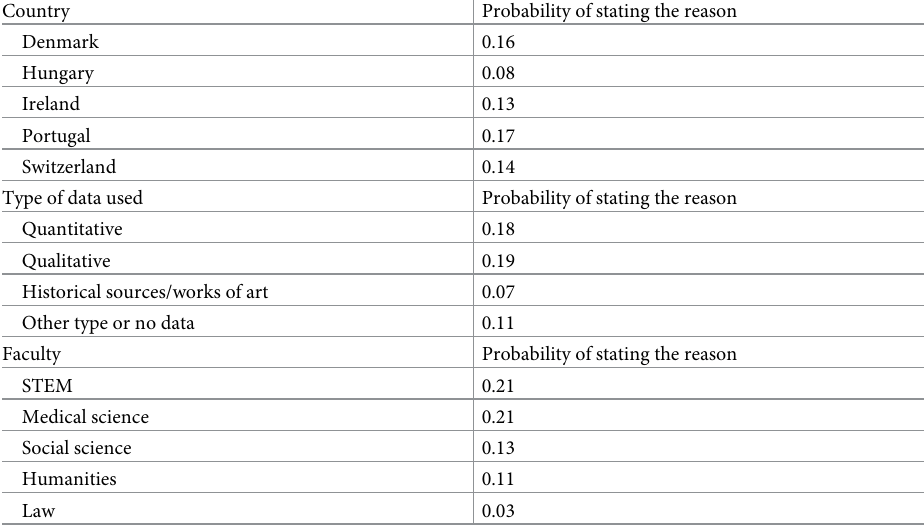
Country shares (but not Type of data used) are calculated using the atmeans margins command, so that the shares reflect the same average student across